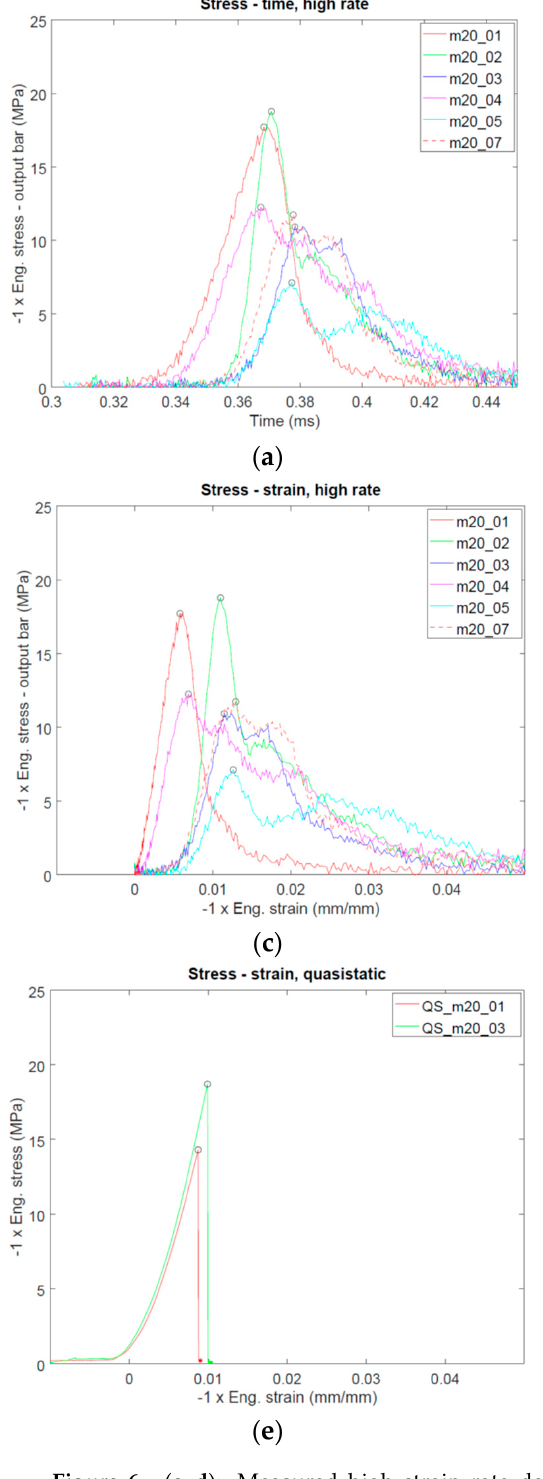
Figure 6. ( a – d ): Measured high strain rate data at − 20 ◦ C: ( a ) stress-time, ( b ) strain rate-time, ( c ) stress-strain, ( d ) stress-strain with curves shifted to common starting point, ( e , f ): measured quasi-static stress-strain data at − 20 ◦ C: ( e ) tests with smooth stress-strain curve until maximum stress and ( f ) tests with intermittent drops in stress before maximum